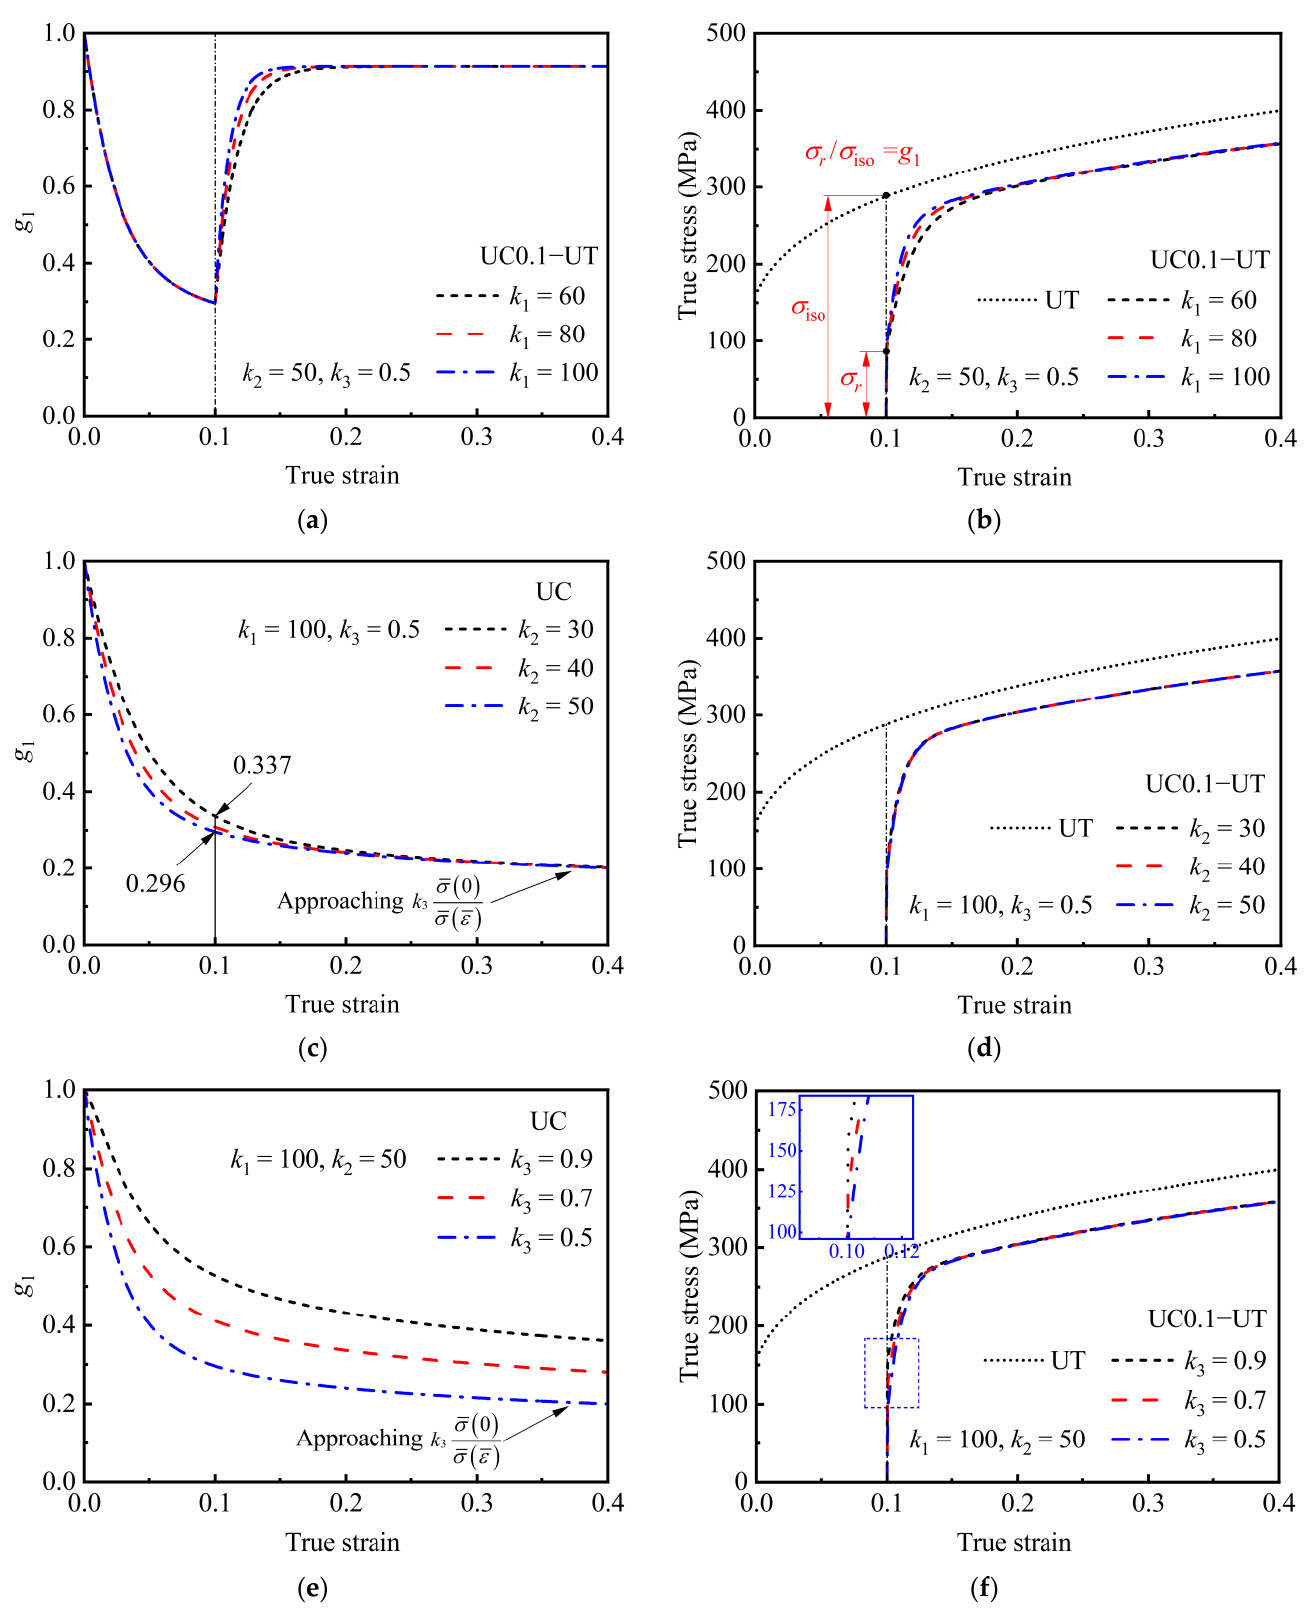
Figure 6. Predicted responses of the Bauschinger effect during reverse loading; evaluation of g 1 during ( a ) UC0.1 − UT loading under different k 1 ; ( c ) UC loading under different k 2 ; and ( e ) UC loading under different k 3 ; and stress–strain curves during UC0.1 − UT loading under ( b ) different k 1 ; ( d ) different k 2 and ( f ) different k 3